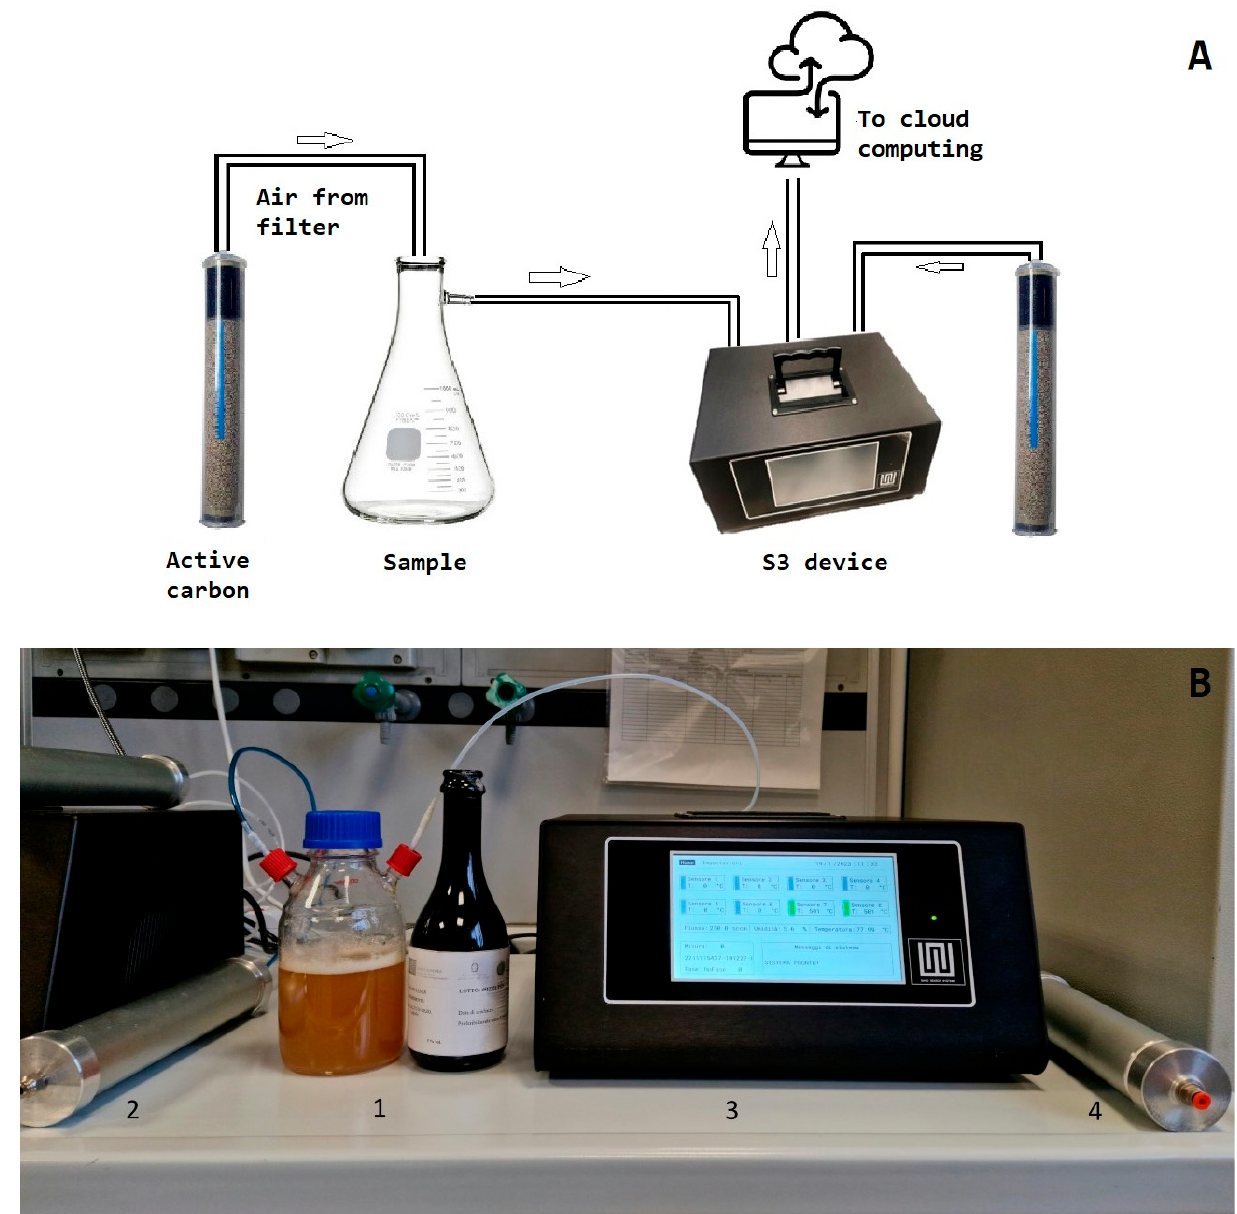
Figure 1. ( A ) Schematic representation of the instrumental analysis setup. ( B ) Analysis conducted on a lager beer sample. Beer is stored inside a three-hole Pyrex flask (1). One hole is closed, while the others two are connected with an active carbon filter (2) on the left exit and the S3+ device (3) on the right exit. Filtered lab air was used as the carrier gas. Furthermore, the S3+ device was connected to a second active carbon filter (4) to reduce the environmental contribution during the signal